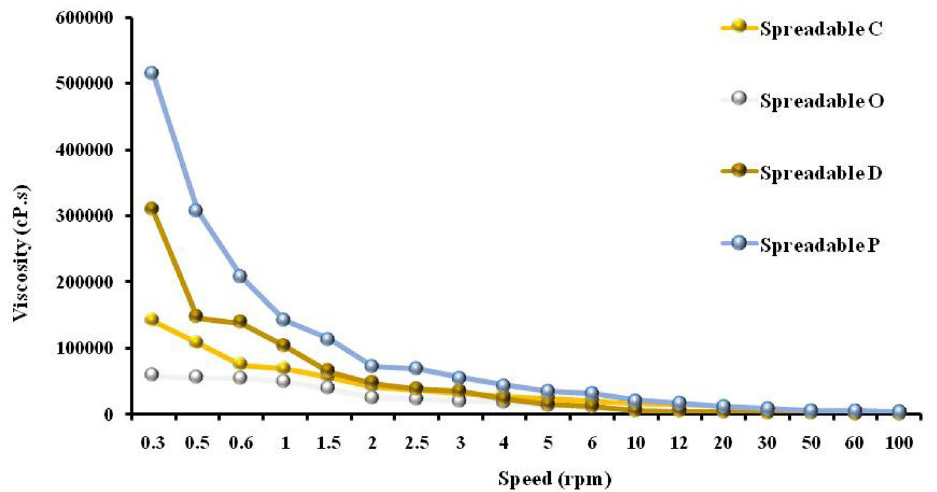
Figure 3. Viscosity of functional spreadable (O, P, D, and C)